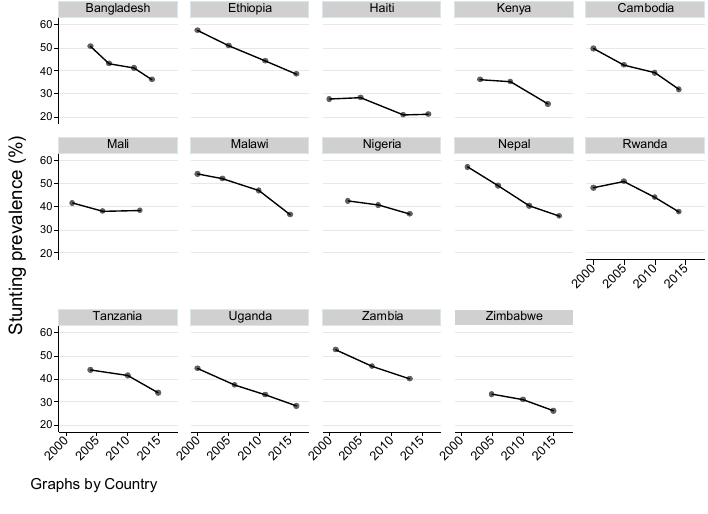
Figure 1. Trends in under-five stunting prevalence by country.